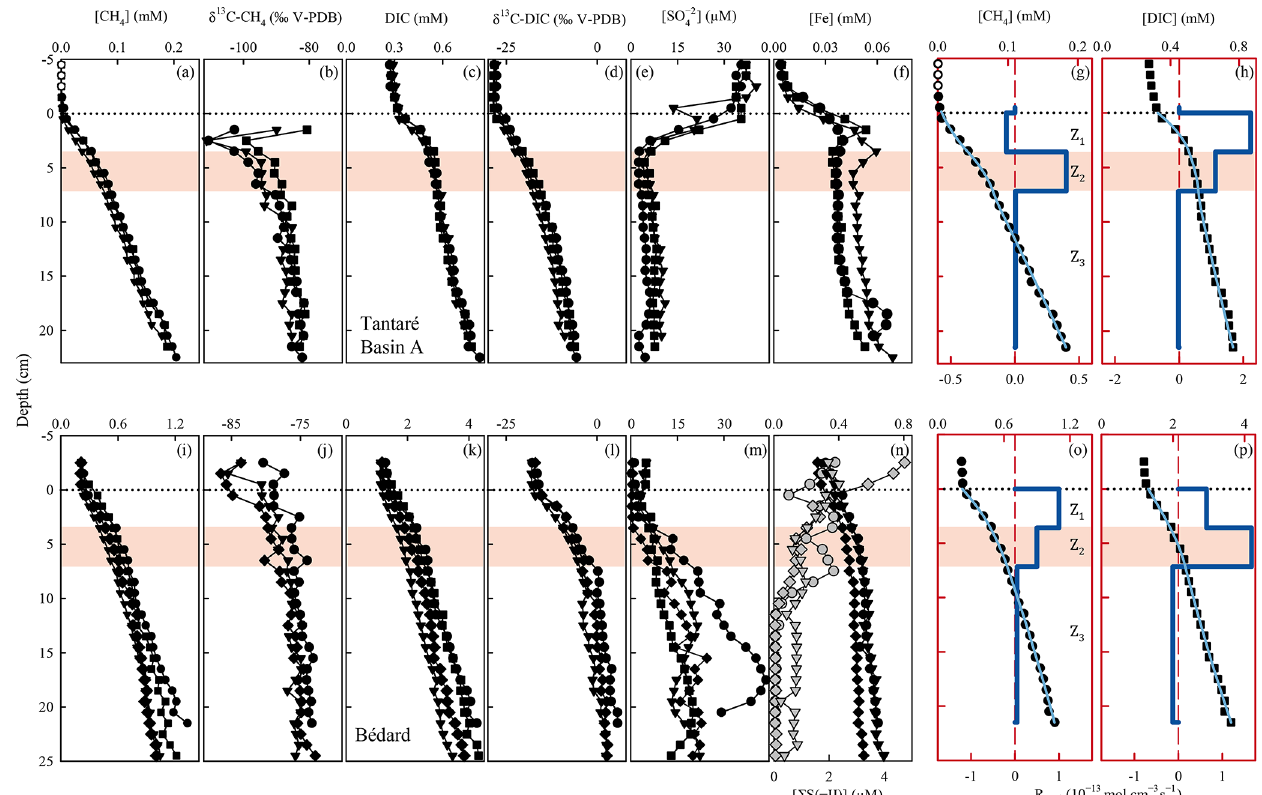
Figure 3. Replicate porewater profiles of CH 4 (a, i) , δ 13 C–CH 4 (b, j) , DIC (c, k) , δ 13 C–DIC (d, l) , SO 2 − comparison of the modelled (blue lines) and average ( n = 3) measured (symbols) concentration profiles of CH 4 (g, o) and DIC (h, p) in Lakes Tantaré Basin A (a–h) and Bédard (i–p) . Different symbols indicate data from different peepers and empty symbols are for concentrations below detection limit. The horizontal dotted line indicates the sediment–water interface. The thick and thin blue lines represent the net solute reaction rate ( R solute net ) and the modelled concentration profiles, respectively. The red area fills correspond to the sediment zones Z 2